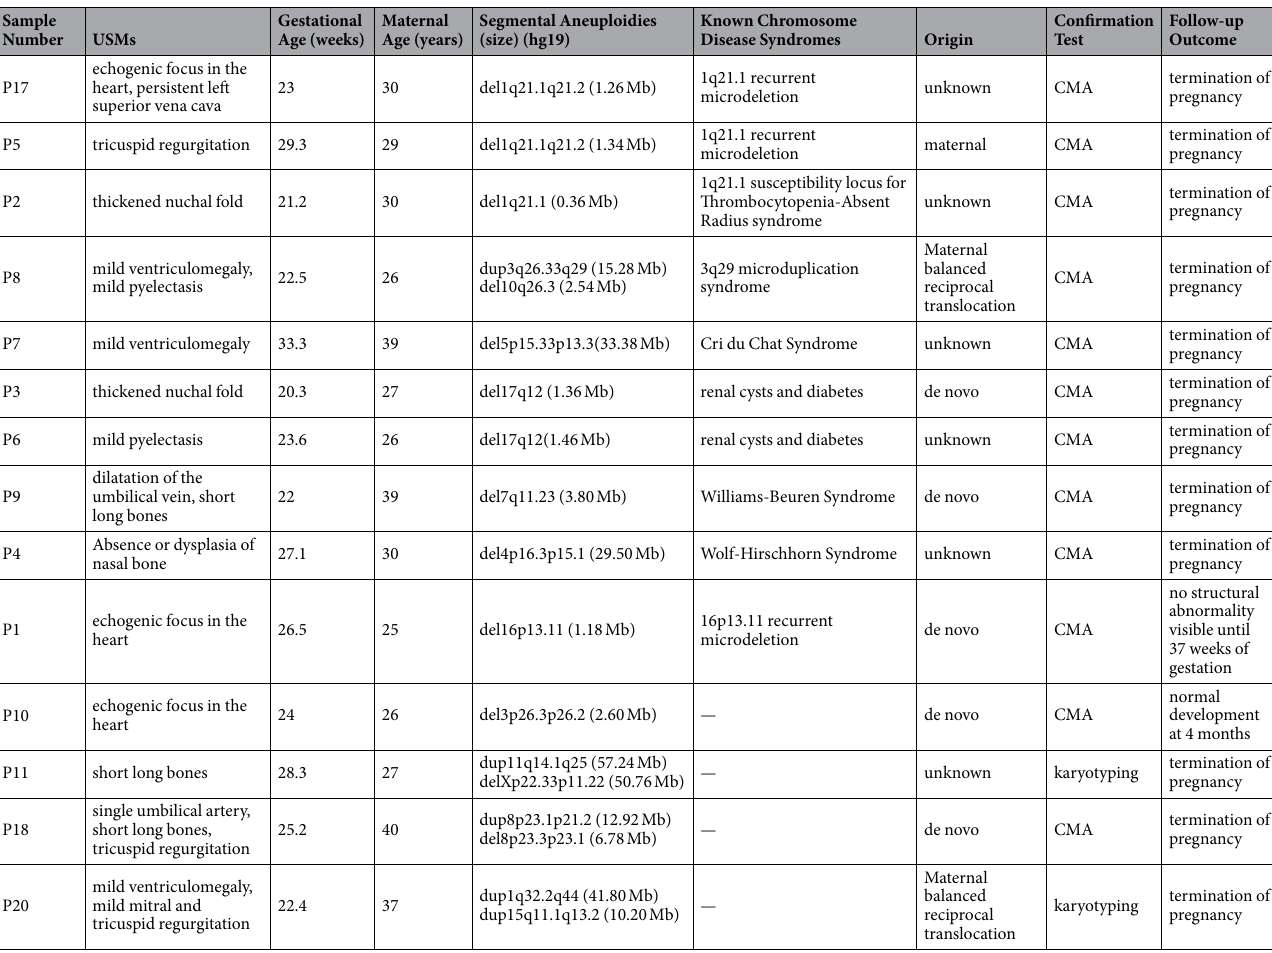
Table 3. Segmental aneuploidies of the 782 fetuses with